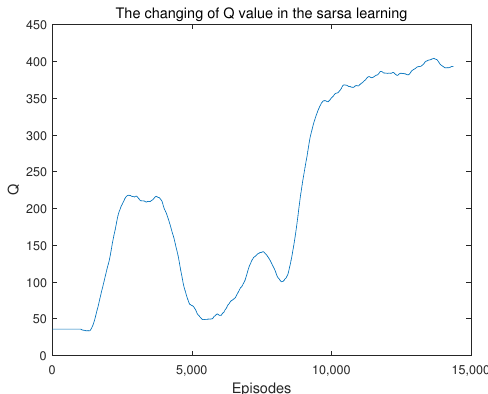
Figure 7. The Q -value for each episode in the policy learning.